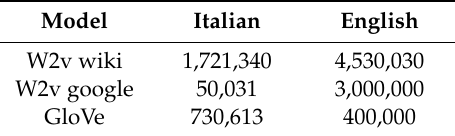
Table 4. Dimensions of pre-trained models